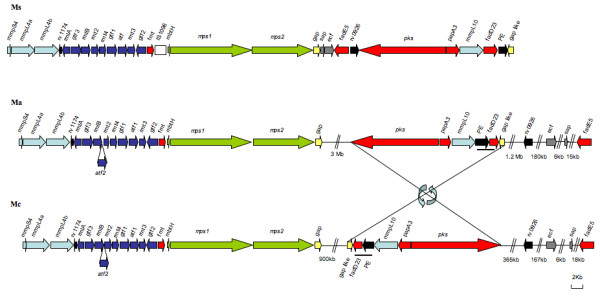
Genetic organization of the GPL locus in M. smegmatis (Ms), M. abscessus (Ma), and M. chelonae (Mc). The ORFs are depicted as arrows and have been drawn to scale. Colour code: Light blue: mmpL family, black: unknown, purple: sugar biosynthesis, activation, transfer and modifications, red: lipid biosynthesis, activation, transfer and modifications, green: pseudopeptide biosynthesis, yellow: required for GPL transport to the surface, grey: regulation.